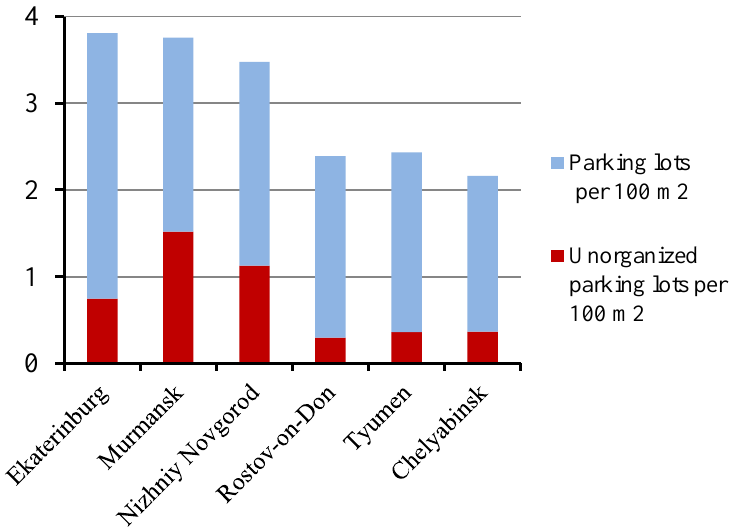
Figure 5. The numbers of proper and illegal parking places per 100 m 2 of the motor transport infrastructure zone of the EURL internal part.